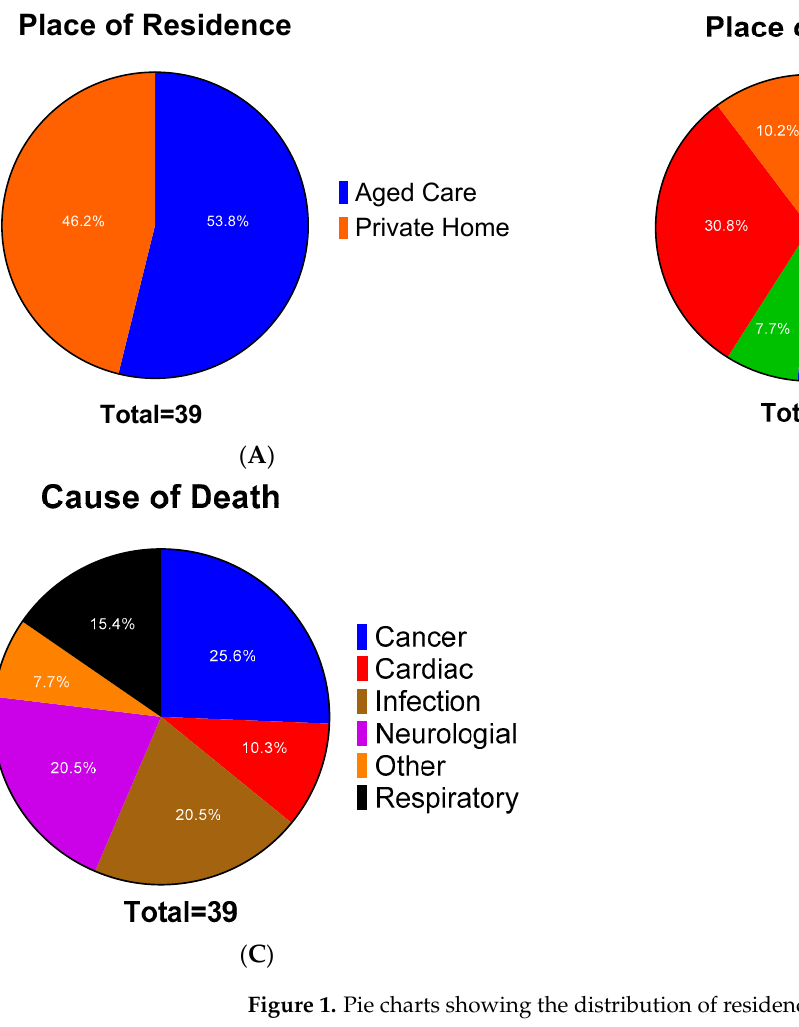
Figure 1. Pie charts showing the distribution of residence ( A ), place ( B ), and cause of death ( C ). Pie charts that show the distribution of the different metrics. The number in the segments shows the percentage. n = 39.